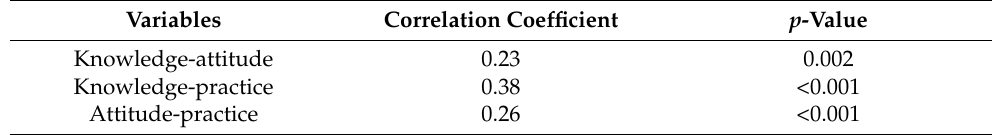
Table 5. The correlation between knowledge, attitude, and practice of ABU and